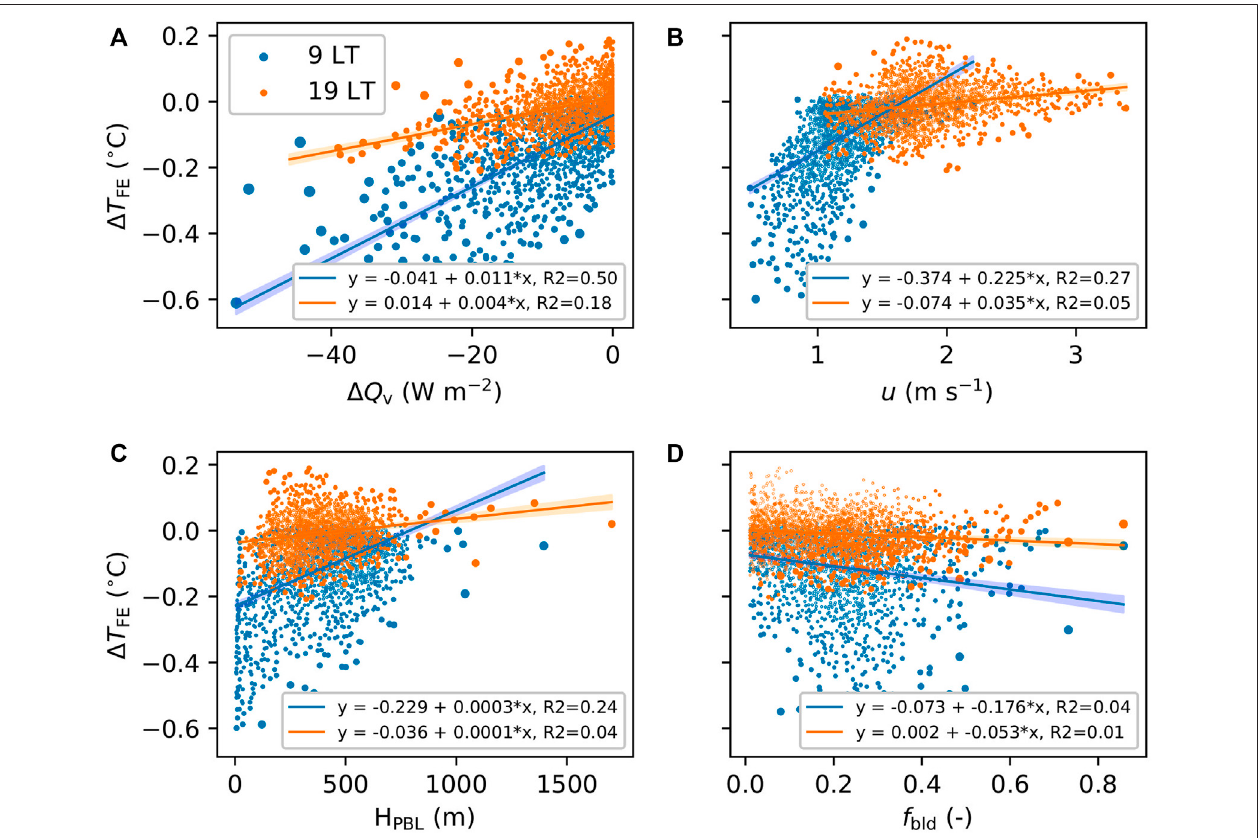
FIGURE3| The contrastingresponsebetweenmorningandeveningtraf fi cpeak maybe attributed tochangesin atmospheric conditions. Scatterplotsoftheheat mitigation ( Δ T FE ) of FE at 9 and 19 LT against the (A) reduction in traf fi c heat emissions ( Δ Q v ), (B) near-surface wind speed ( u ), (C) boundary layer height (H PBL ) and (D) fraction of building surfaces (f bld ). The plot uses period-average hourly values. The solid lines and shaded areas represent the linear regression and the corresponding con fi dence intervals (95%), respectively.